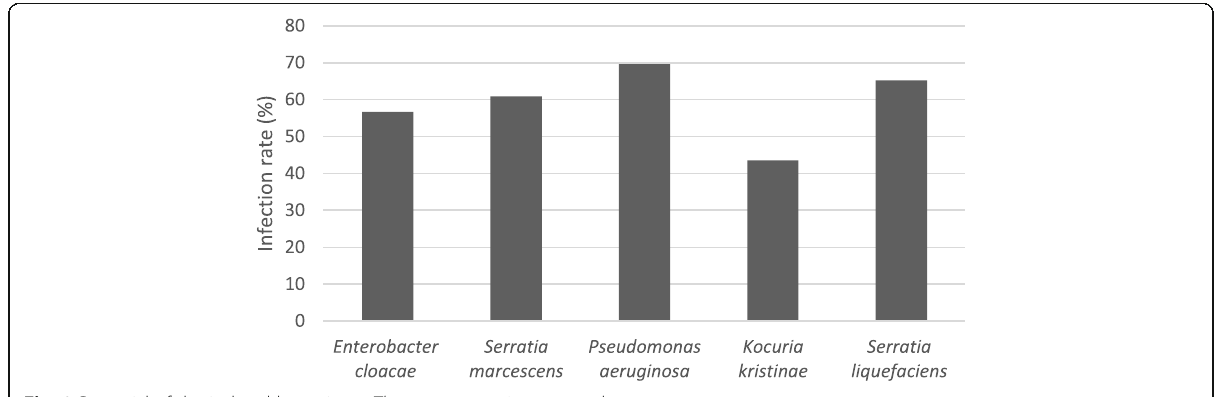
Fig. 2 Potential of the isolated bacteria on Thaumetopoea pityocampae